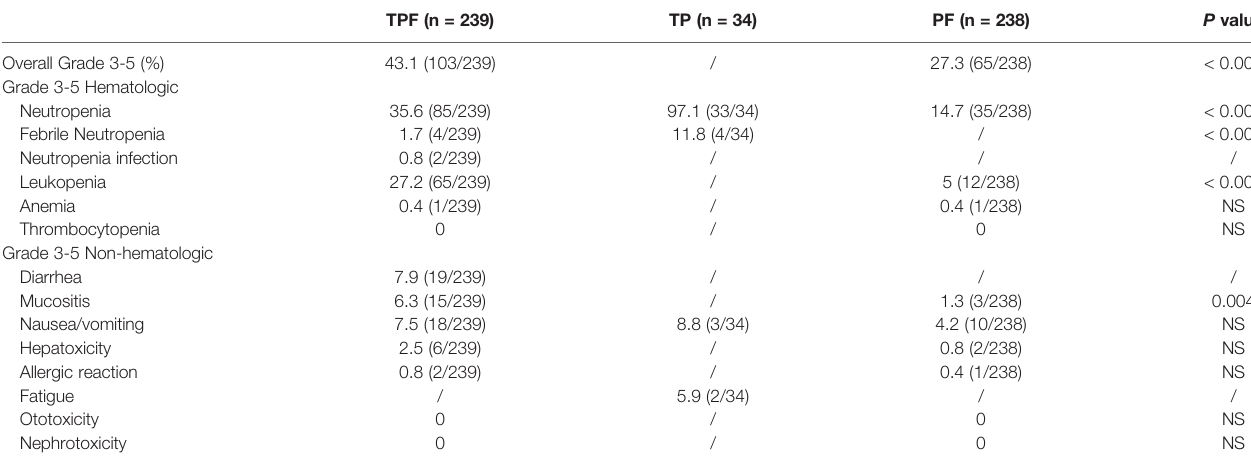
TABLE 3 | Acute toxicity comparison during induction